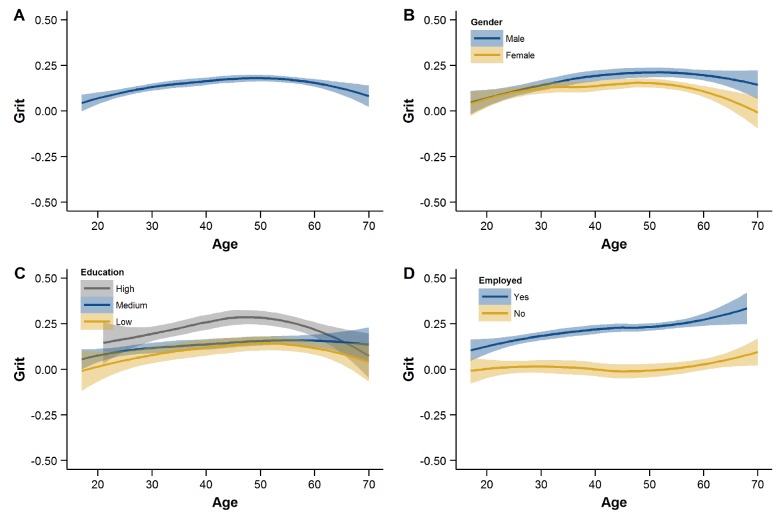
Age profiles of grit.LOESS curves (A) for the full sample, (B) by gender, (C) educational attainment, and (D) employment status. Values on the Y-axis are standardized factor scores.